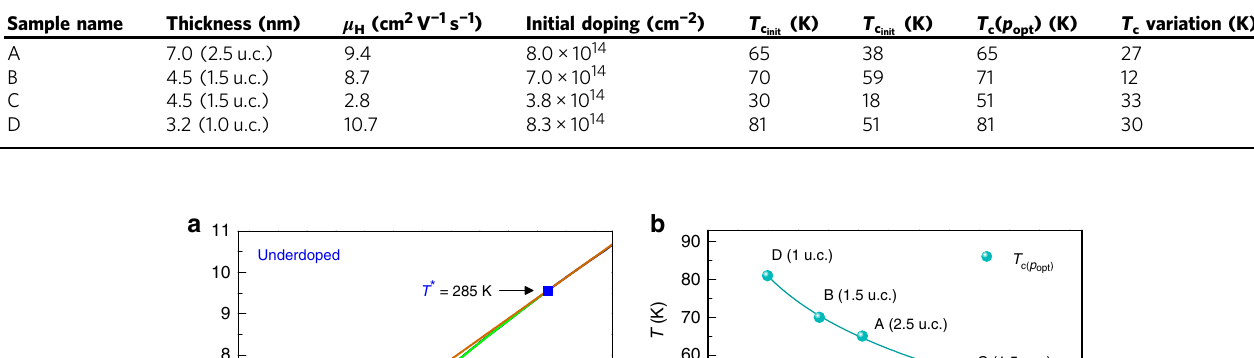
Table 1 BSCCO-2212 device characteristics